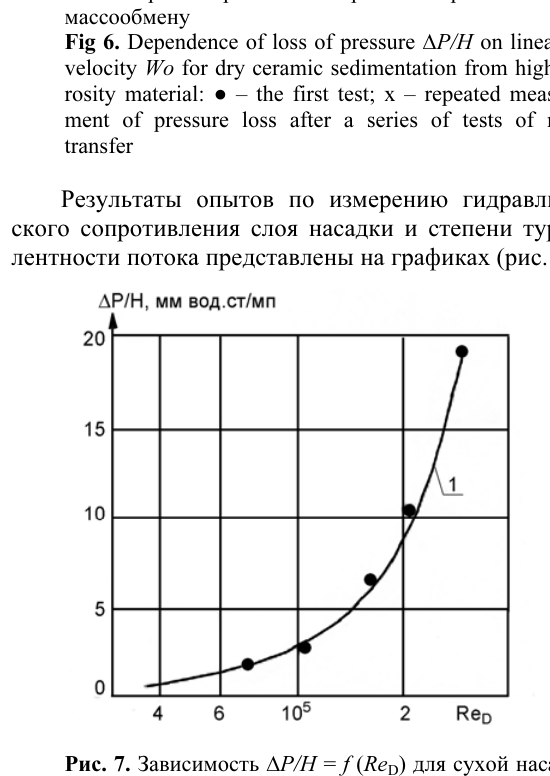
Рис. 7. Зависимость ∆ P/Н = f ( Re D ) для сухой насадки пор d э = 1.8 мм Fig 7. Dependence ∆ P/Н = f ( Re D ) for dry sedimentation from ceramic high porosity material with equivalent diameter of pore d e = 1.8